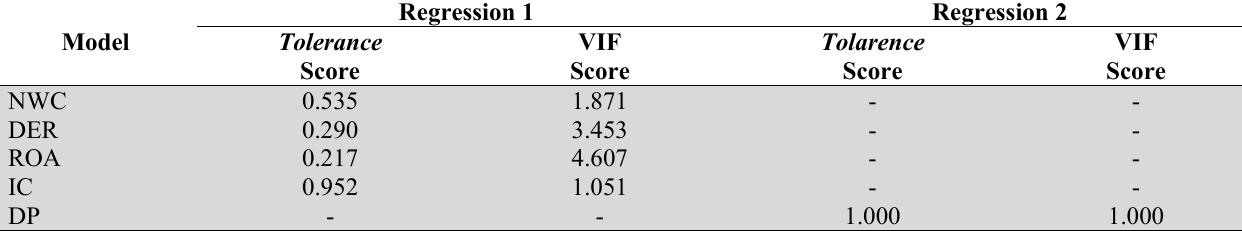
Summary of Multicolinearity